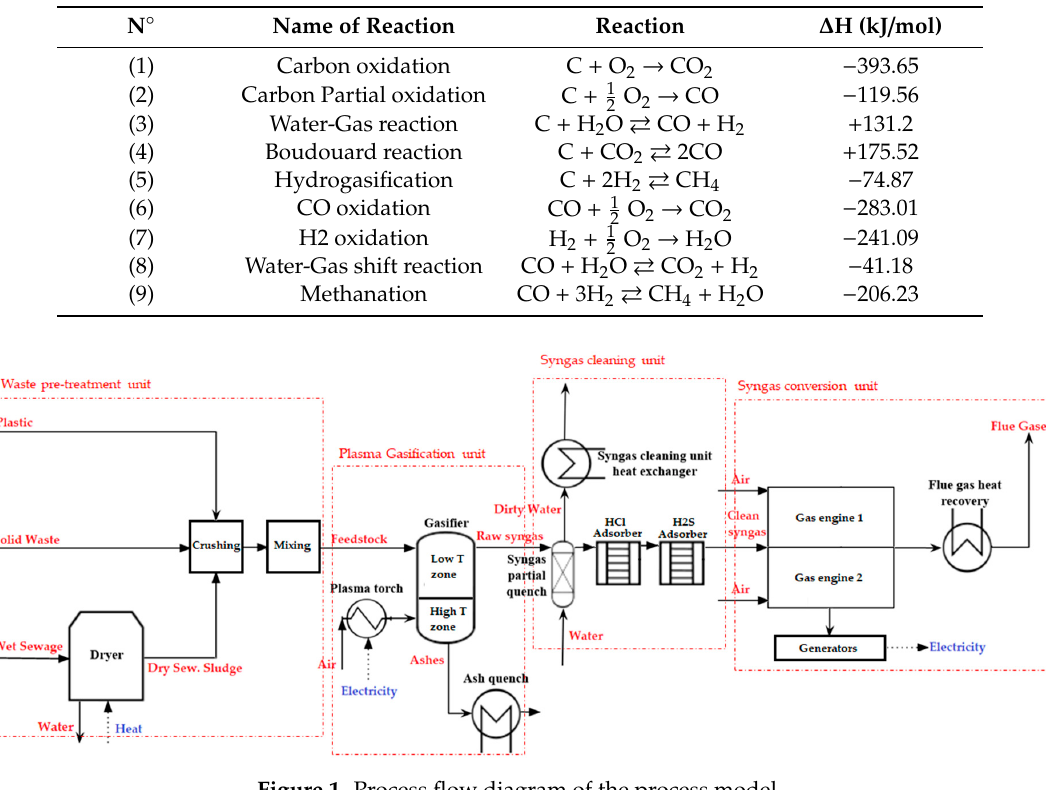
Figure 1. Process flow diagram of the process model.